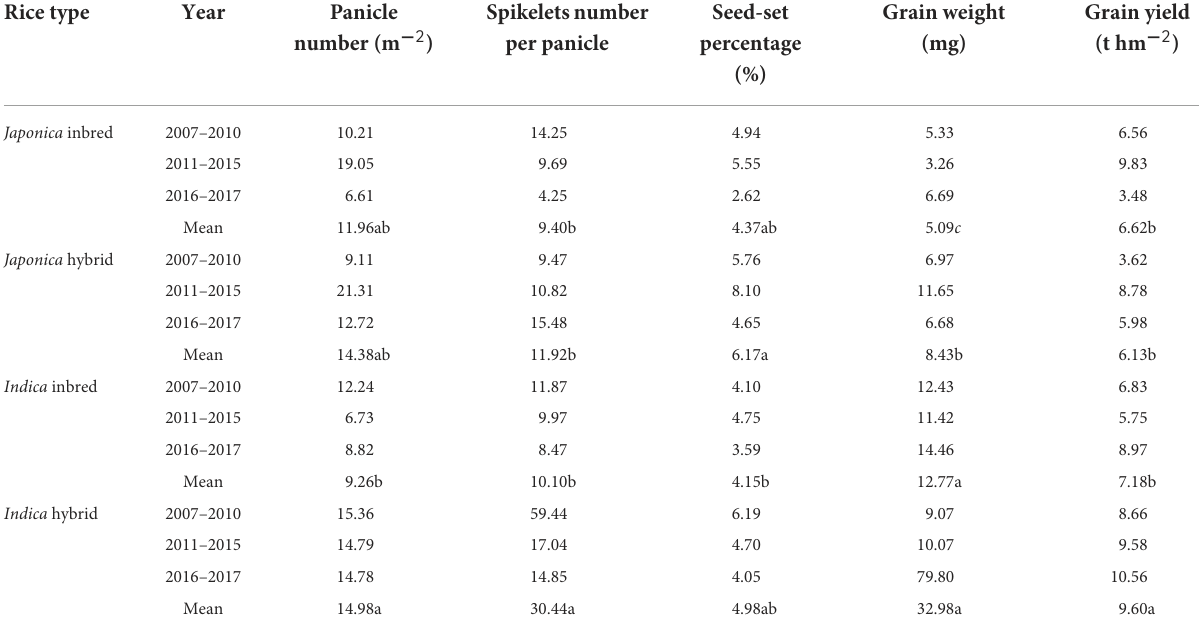
TABLE 4 Variation coefficients for the yield traits of the released inbred and hybrid rice varieties. Rice type